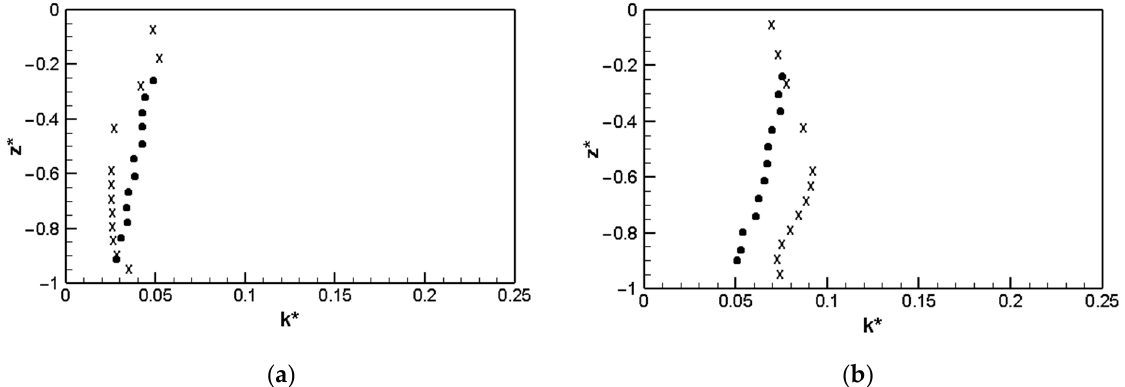
Figure 15. Results 6: time mean turbulent kinetic energy profiles in Configuration WKI, showing numerical results (X) and experimental results (circles) [3]. ( a ) x = 7.27 m, ( b ) x = 7.88 m, z ∗ = ( z − η ) / H and k ∗ = k / gH .